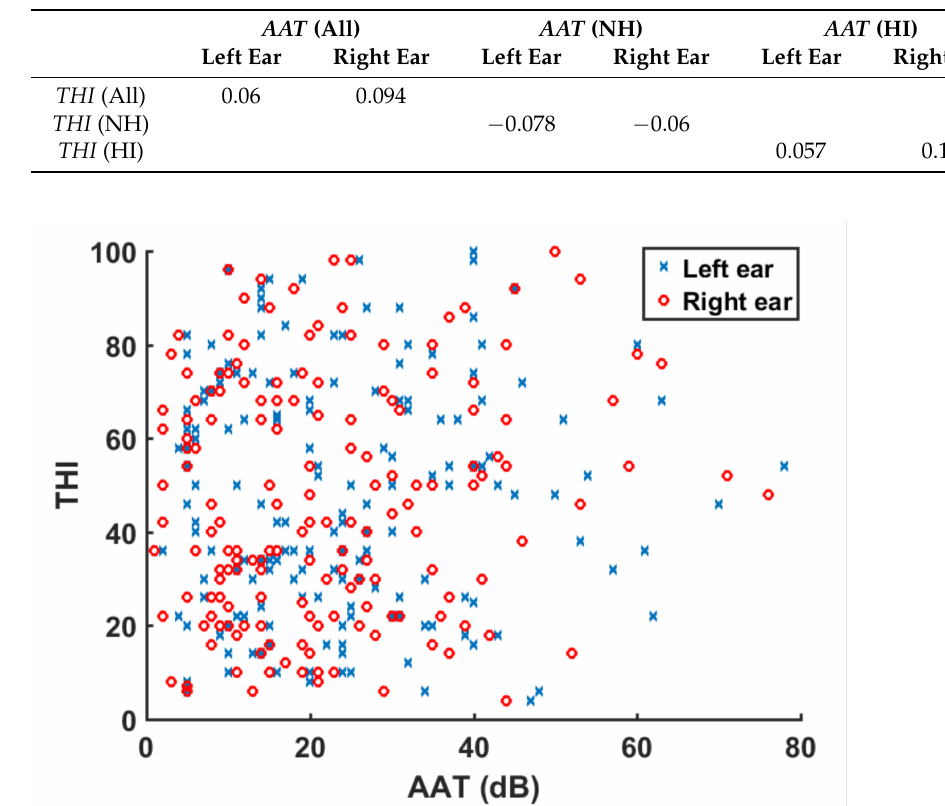
Table 4. Spearman rank correlation factors between variables.